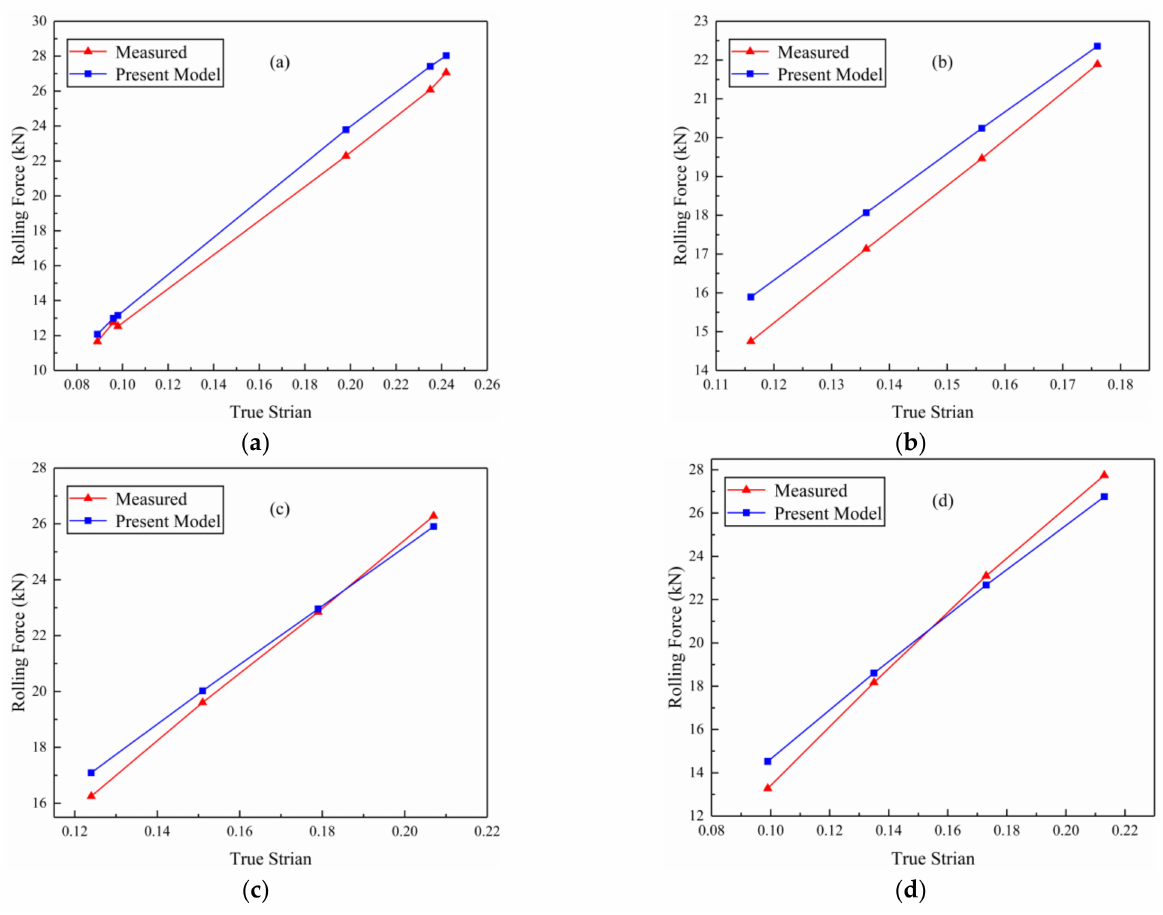
Figure 8. Comparison of theoretical model results and experimental results. The roll gap change velocity are respectively: ( a ) 0 mm/s; ( b ) 0.035 mm/s; ( c ) 0.047 mm/s; ( d ) 0.065